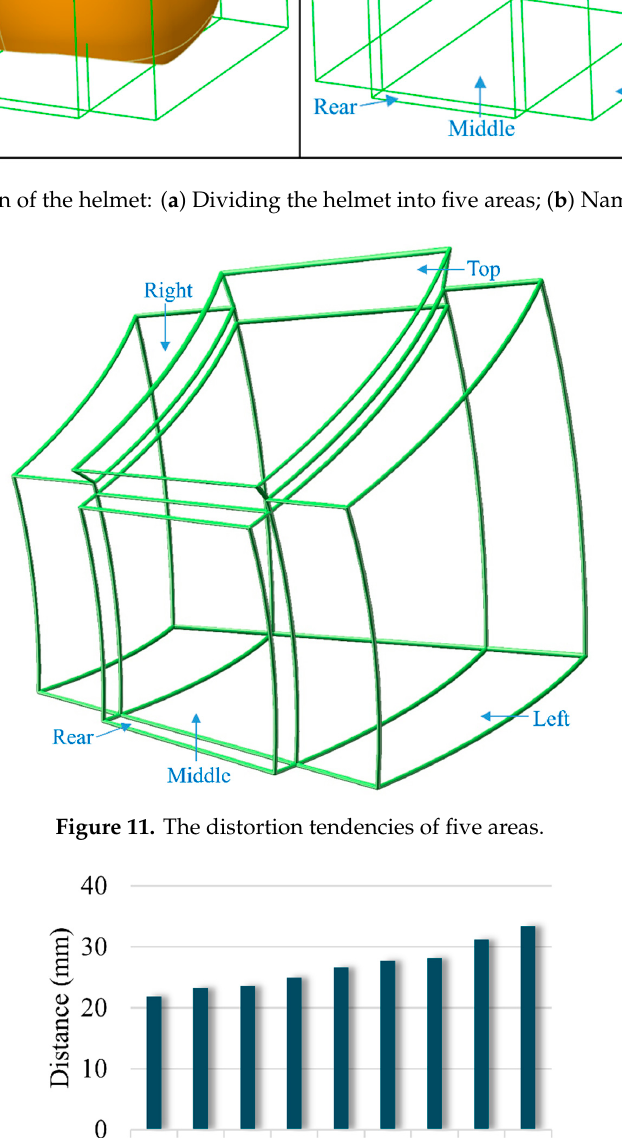
Figure 12. Total deformation results of nine helmets.